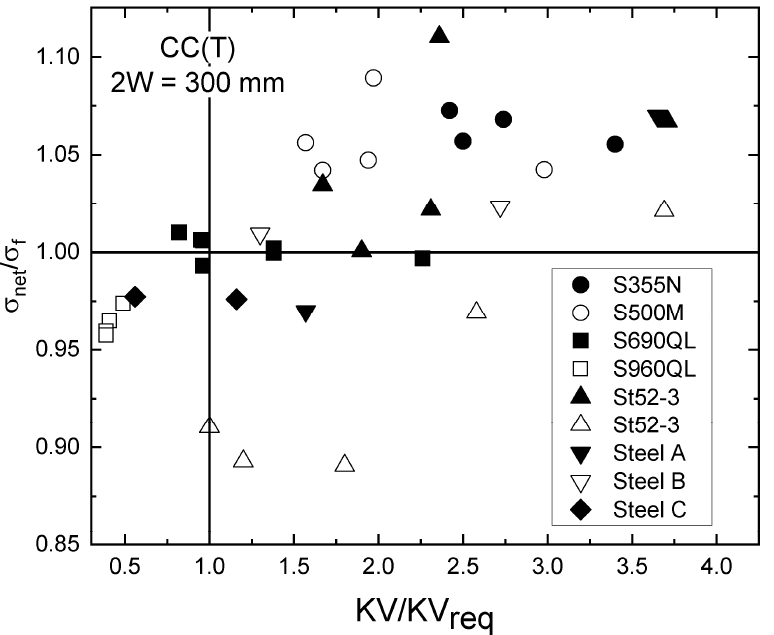
Figure 13. Compilation of proportional net section stress divided by flow stress as a function of ratio between the Charpy-V impact energy and estimated required impact energy to obtain the plastic limit load.